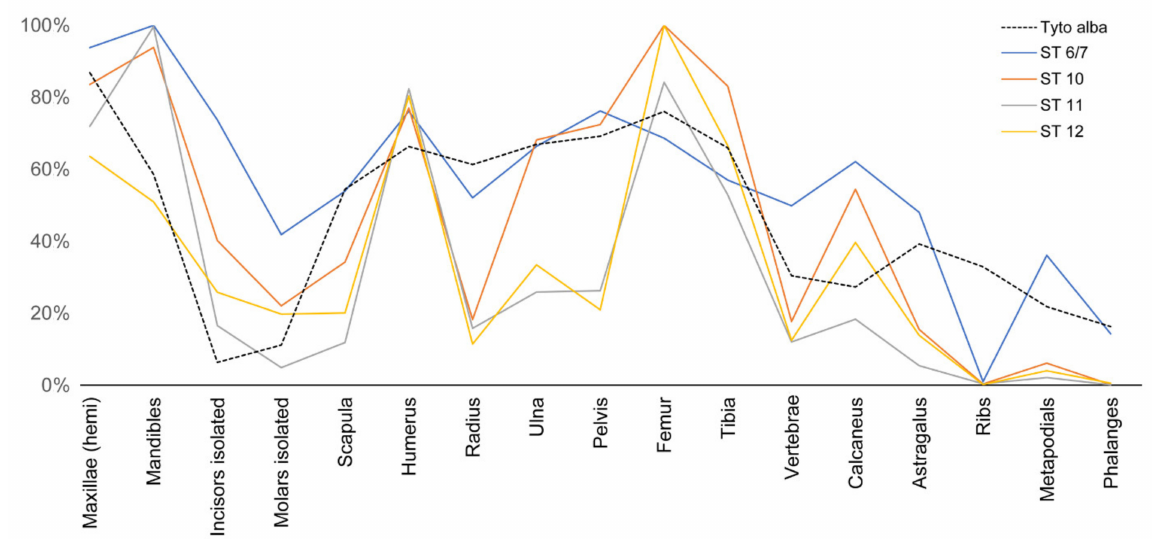
Figure 12. Diagram showing the relative abundance of skeletal elements in individual strata from Wonderwerk Cave (from [30]) compared to a modern barn owl ( Tyto alba ) assemblage [11]. Note that all strata show a high degree of homogeneity and have a relatively high frequency of calcanei and astragali. Note also that all samples have fewer astragali than calcanei, likely because the former inci- dentally broke during post-depositional taphonomic processes (as seen in our trampling/compression experiment) and possibly got lost during sample processing (i.e.,